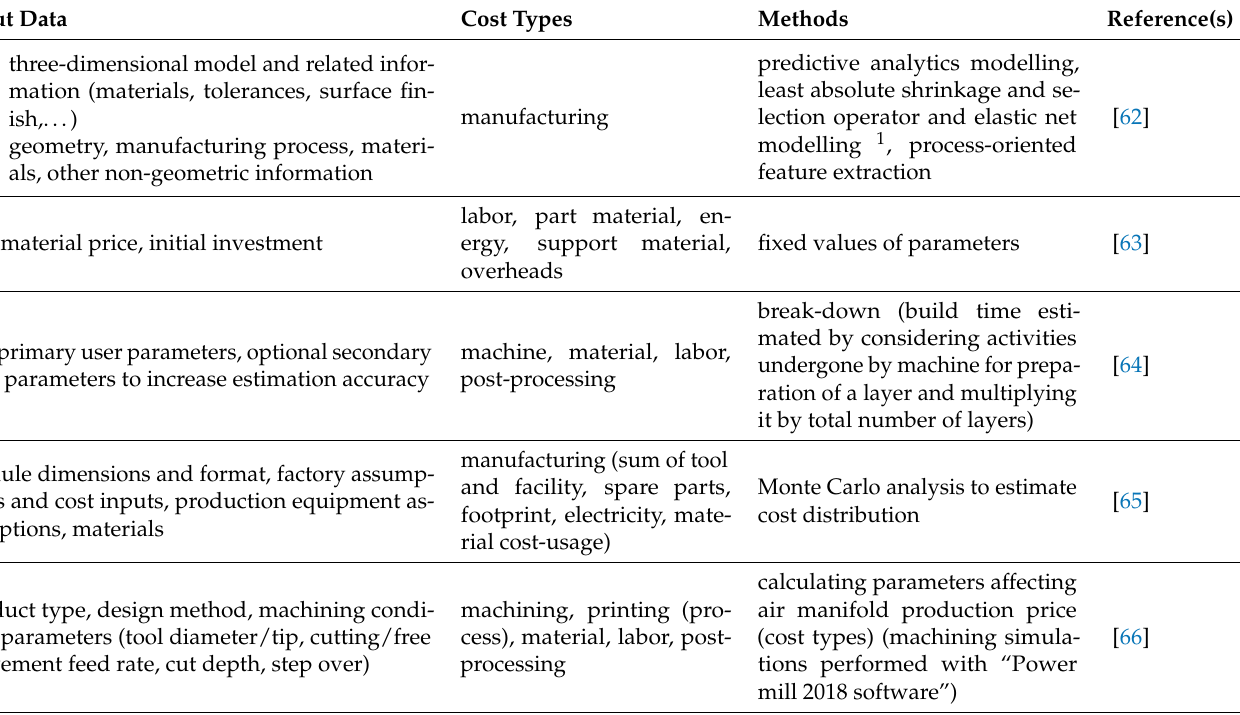
Table 2. Relation among data, cost types and methods based on bibliography about cost analysis and cost modelling